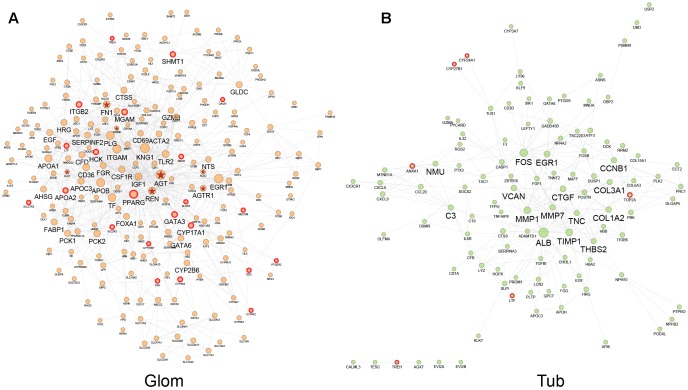
Interaction network of DEGs in glomeruli (A) and tubules (B). Node size changes with the node degree in network. The hub nodes were marked with big name labels and potential drug targets of QDZJN were marked with red edges. Nodes with red star label were disease genes related to HN from DisGeNET database.